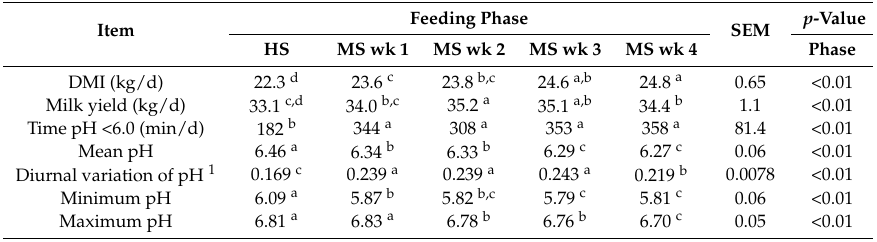
Table 2. Dry matter intake (DMI), milk yield, and reticuloruminal pH in cows fed either a 40% concentrate diet high in physical structure (24.4% peNDF > 8 mm DM basis; HS) or a 60% concentrate diet with moderate physical structure content (17.6% peNDF > 8 mm; MS wk 1–4).